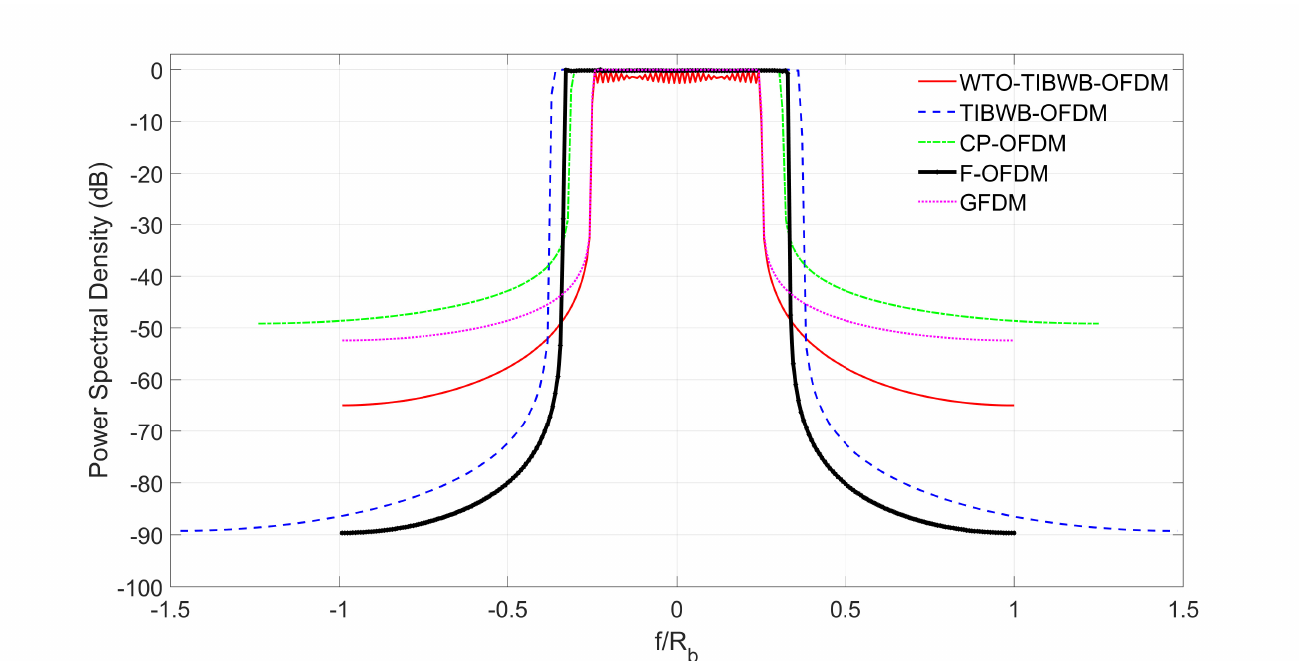
Figure 6. PSD of CP-OFDM, GFDM, F-OFDM and TIBWB-OFDM with and without